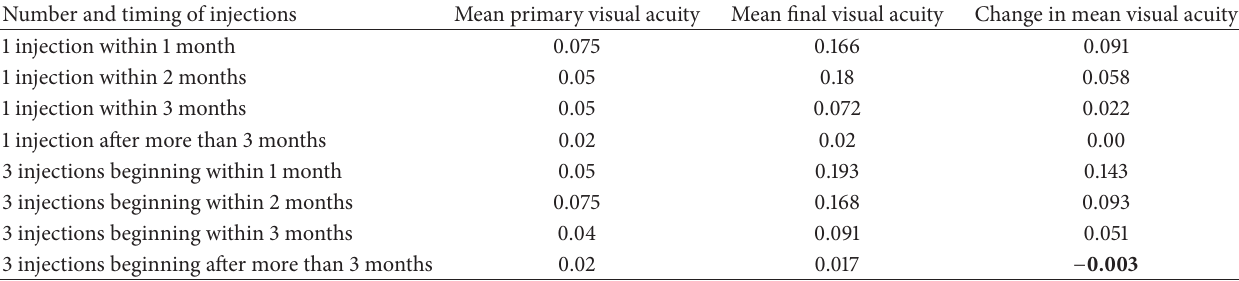
Table 2: Mean change of visual acuity by the time from the CRVO event to the first Avastin injection and the regimen of injections